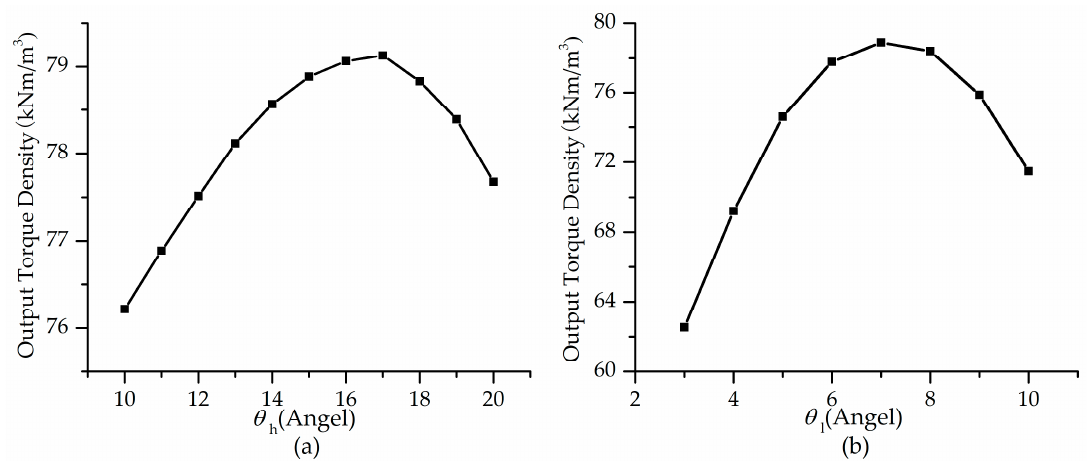
Figure 9. Output torque density curves versus θ h and θ l . ( a ) Mechanical angle of each axially magnetized PMs on the high-speed rotor; ( b ) Mechanical angle of each axially magnetized PMs on the low-speed rotor.